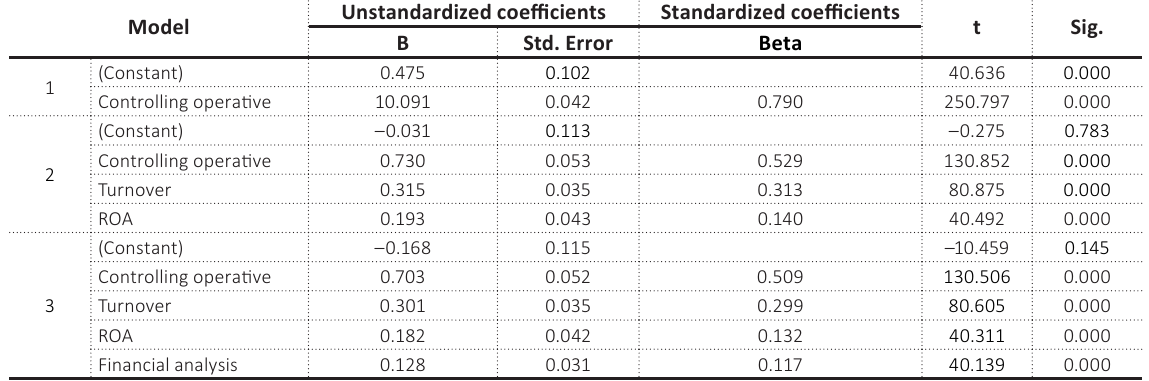
Table 2. Model construction, dependent variable Strategic management